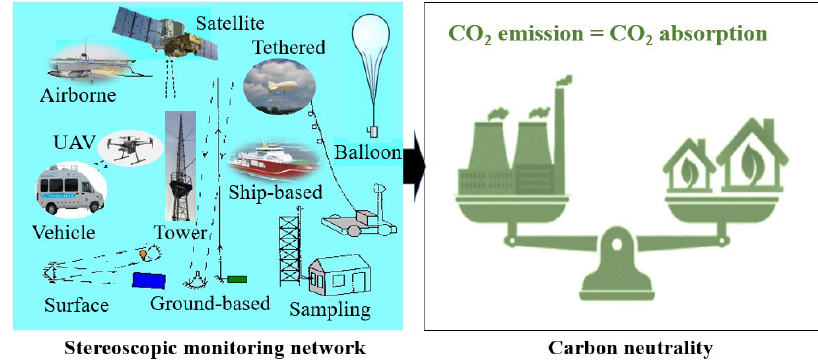
Figure 5. Stereoscopic GHG monitoring network to support carbon peak/neutrality in